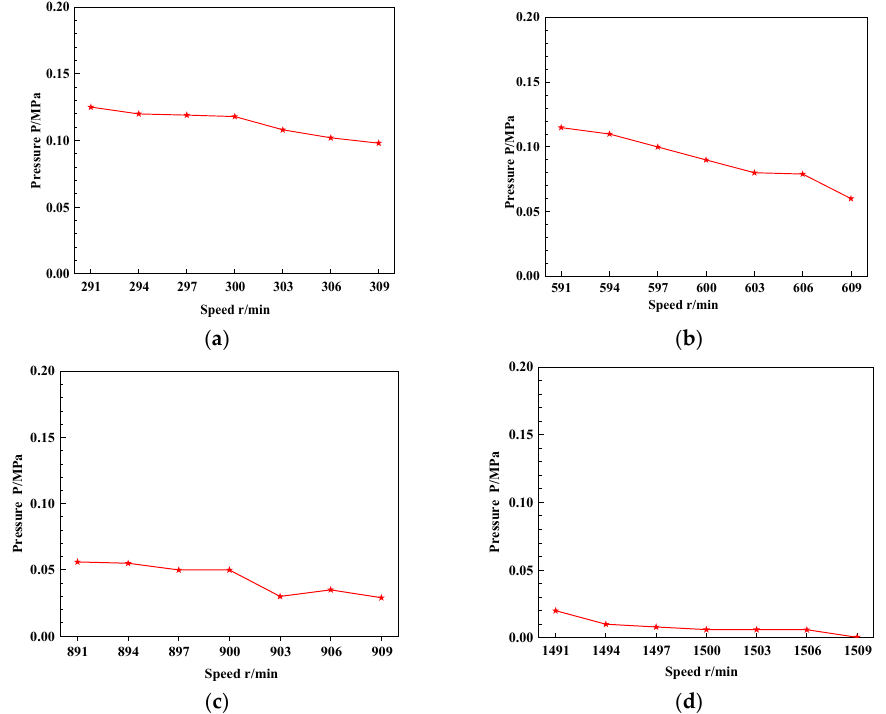
Figure 5. Pressure curve of the MR fluid seal under different speed conditions: ( a ) 300 rpm; ( b ) 600 rpm; ( c ) 900 rpm; and ( d ) 1500 rpm). ( c ) 900 rpm; and ( d ) 1500